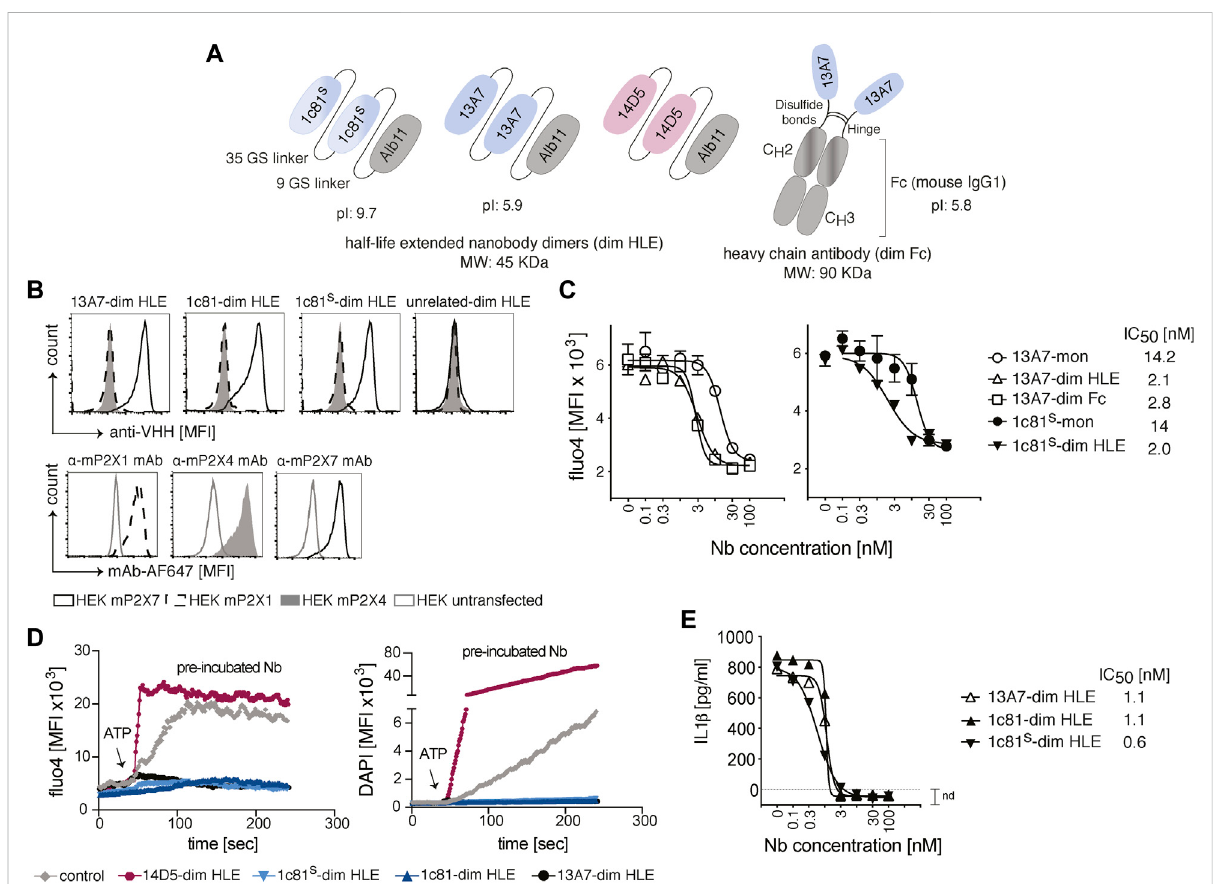
FIGURE 1 Engineering and functional characterizationof P2X7nanobodies for brain targeting. (A) Schematic representation of half-life extended bivalent mouse P2X7-speci fi c nanobodies 1c81 s , 13A7 and potentiator 14D5 fused to an albumin speci fi c nanobody, Alb11 (dim HLE) or to the hinge and Fc domain of mouse IgG1 (dim Fc). Nanobody dimers are connected through a 35 Gly-Ser linker and fused to Alb11 with a 9 Gly-Ser linker, or are connected to the Fc domain of mouse IgG1 through the hinge region. The predicted molecular weight of the bi-speci fi c trimers is 45 kDa and that of the reconstituted 13A7 mouse IgG1 heavy chain antibody is 90 kDa. The predicted isoelectric point (pI) for dim HLE formats of 1c81 s and 13A7 and dim Fc format of 13A7 is shown. (B) Binding of P2X7 nanobodies to mouse P2X1, P2X4 or P2X7 on the cell surface of HEK cells co- transfected with GFP and the respective P2X receptor. Bound nanobodies were detected with anti-VHH monoclonal antibody mAbH0077 followed by a BV421-conjugated anti-mouse IgG1 antibody (upper panels). As controls, HEK cells were stained with the indicated AF647-conjugated mAbs (lower panel). Gating of transfected HEK cells was performed on GFP + cells (MFI, mean fl uorescence intensity). (C) Functionality of P2X7nanobodies to inhibitthe ATP-dependent channel activation instablemouse P2X7-expressing HEK cells (HEK P2X7 ). HEK P2X7 loaded with the Ca 2+ indicator Fluo-4 were incubated with serial dilutions of monovalent or bivalent HLE nanobodies, and after addition of ATP (1.5 mM), the release of Fluo-4 was monitored over time. The graphs show average Fluo-4 endpoint measurements (n = 3)+/-SD at 20 min. (D) Flow cytometric analysis of function of P2X7 nanobodies on primary murine microglia loaded with Fluo-4 in the presence of DAPI. The fl uorescence intensity was measured for 4 min following addition of ATP (0.5 mM). The 14D5-dim HLE nanobody enhanced P2X7 function and was included as positive control. (E) Functional inhibition of ATP-induced IL-1 β release by primary glial cultures in the presence of bivalent HLE nanobodies. The IL-1 β concentration was measured by ELISA in the supernatant of cells treated with 1.5 mM ATP for 30 min (n = 3, average+/-SD). All IC 50 values were calculated with Prism software. Data are representative of two (B – D) or three (E) independent experiments. Samples in D and E were pooled from two